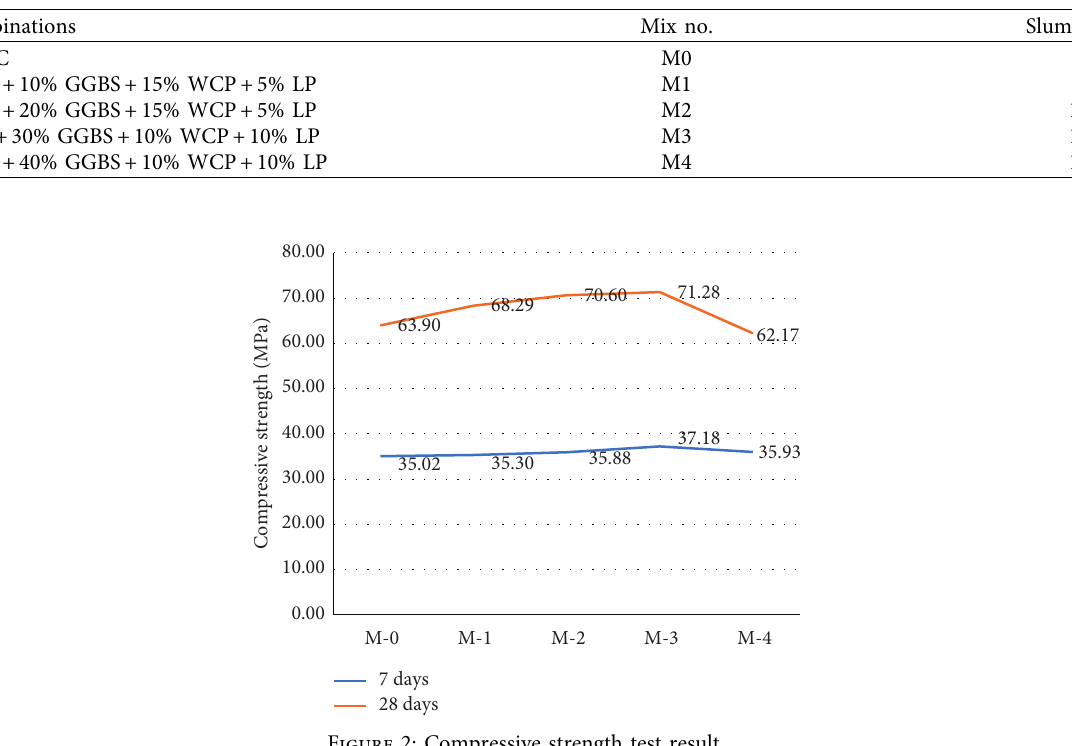
Figure 1: Normal consistency and setting time. Table 3: Comparison of the slump test for the workability study of fresh concrete.